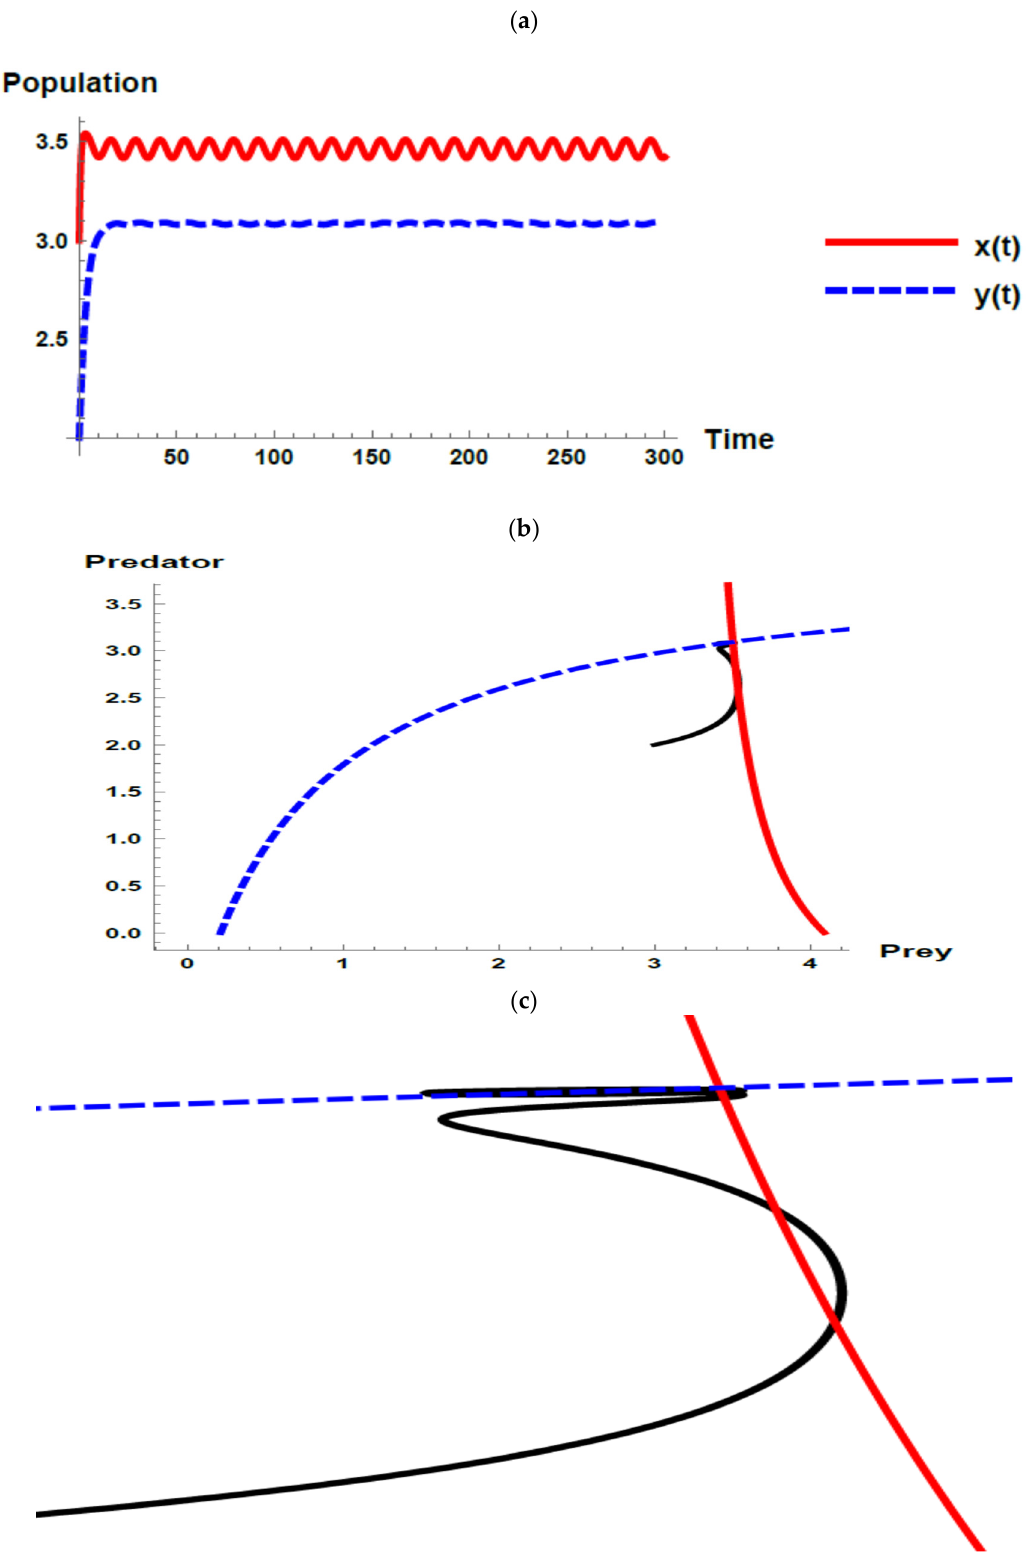
Figure 2. Dynamic behavior of the first set when ( 𝑖 = 0.1 ): ( a ) time series; ( b ) zero-growth isoclines of the prey ( ) and predator ( ) populations and phase plane trajectories; ( c ) cross-sectional picture of ( b ).